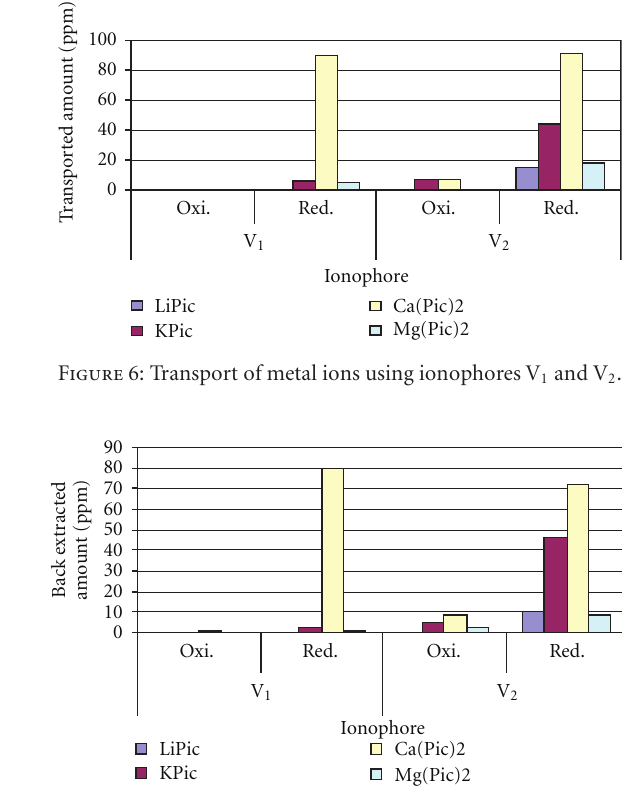
Figure 7: Back extraction of metal ions using ionophores V 1 and V 2 .